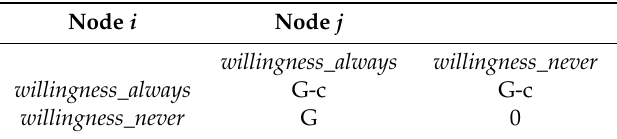
Table 4. Utility function of the i th and j th